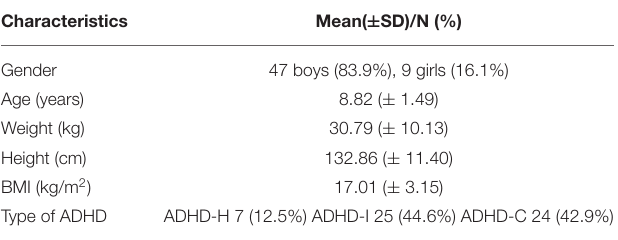
TABLE 1 | Demographic and physical characteristics of the participants ( n = 56).